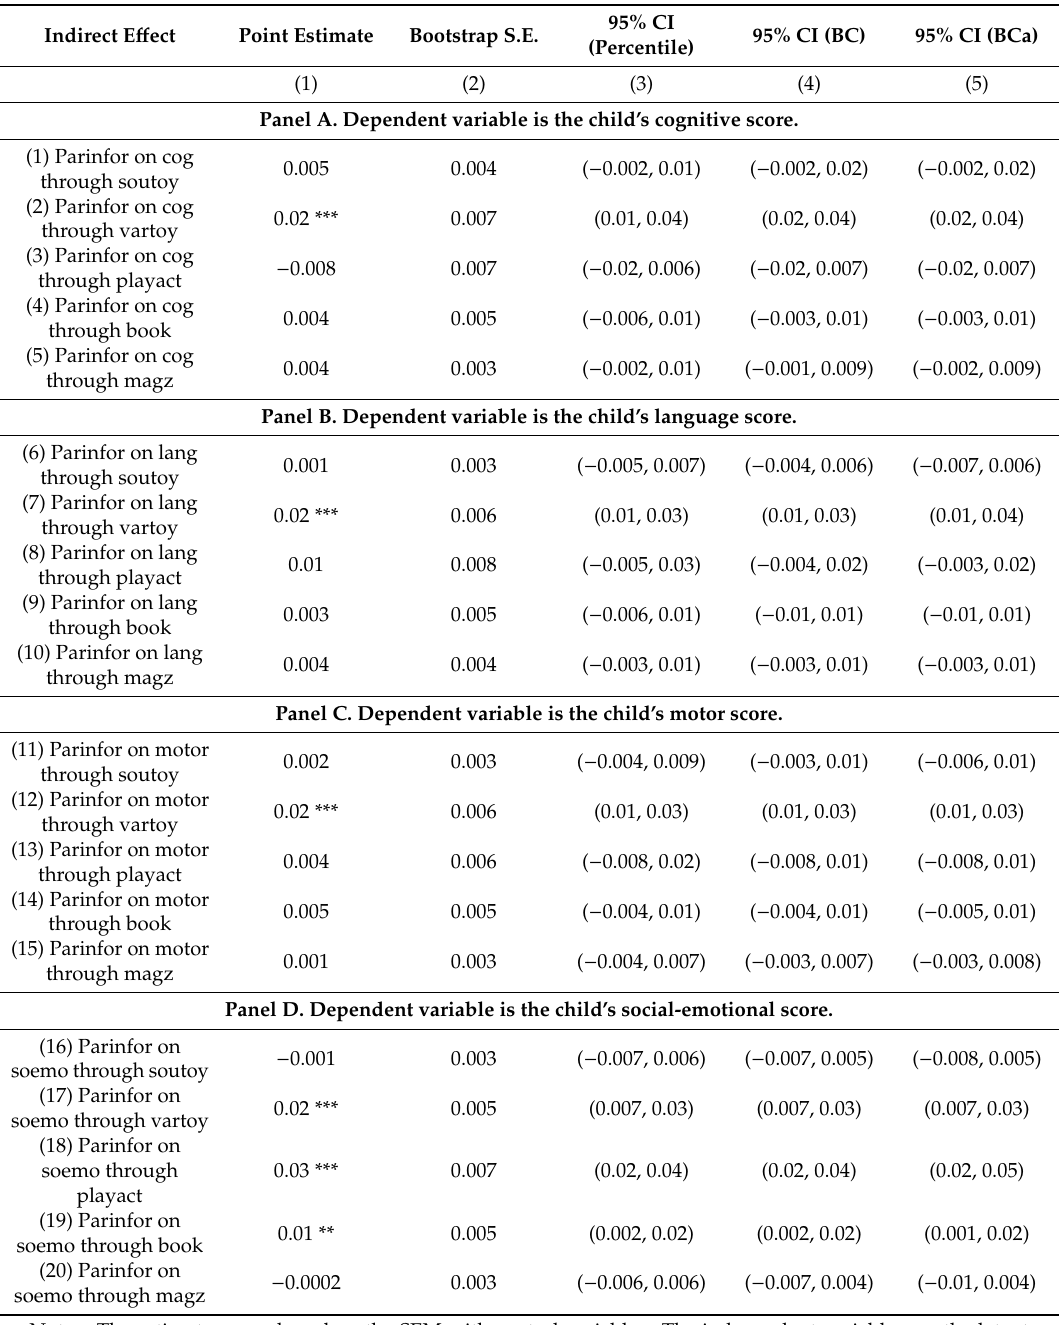
Table 5. Estimates of indirect e ff ects of parenting information on child development through di ff erent components of family care. Indirect E ff ect Point Estimate Bootstrap S.E.